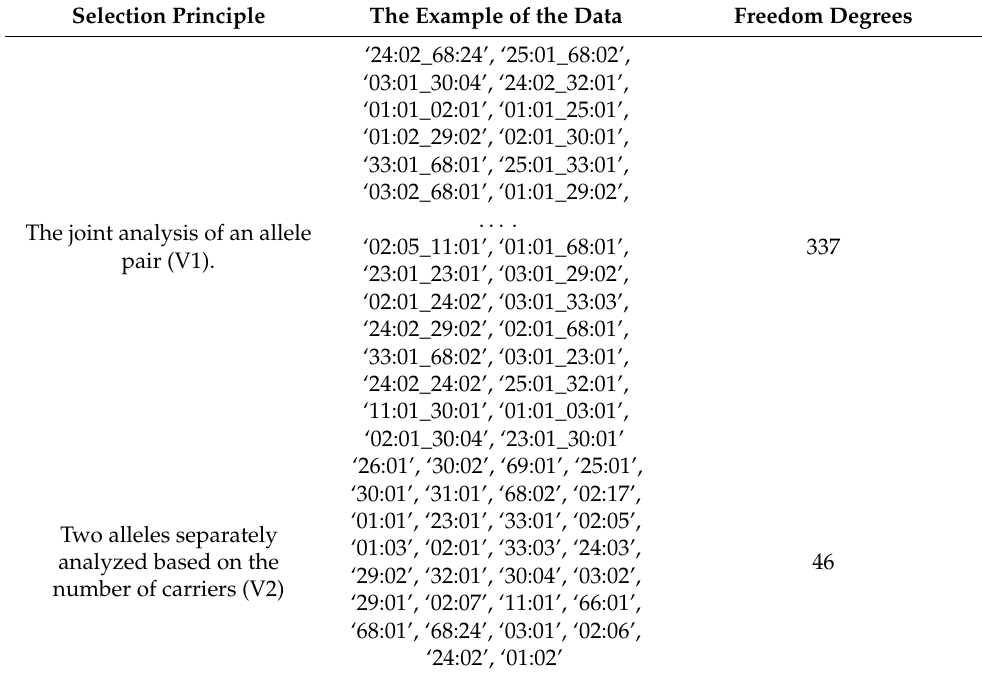
Table 21. The example of using two methods for collecting patient’s data to produce a contingency matrix of an A